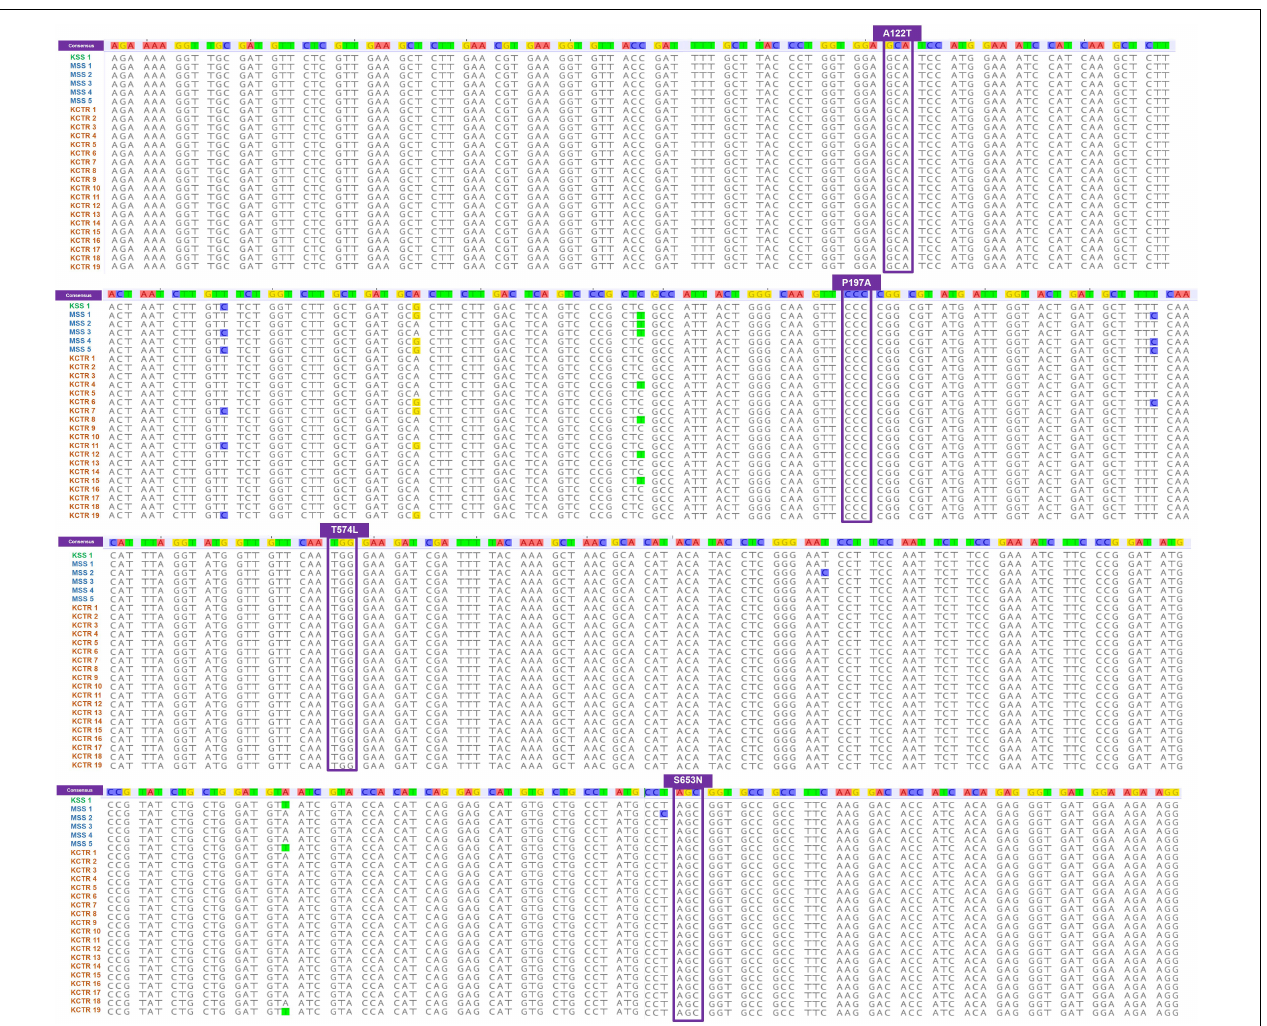
FIGURE 2 | Nucleotide sequence alignment of ALS gene fragment from susceptible (MSS and KSS) and chlorsulfuron (KCTR 1–3)- and imazethapyr (KCTR 4–19)-resistant Palmer amaranth. Nucleotide polymorphisms were observed across KCTR, KSS, and MSS Palmer amaranth, but no amino acid substitutions were found.